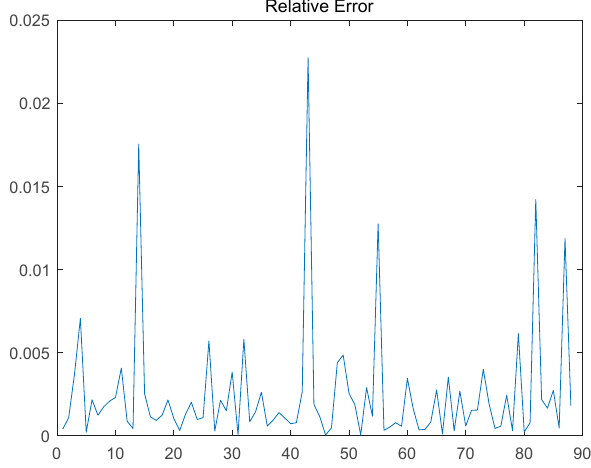
Figure A5. Comparison of output value with expected value of Hugong community.